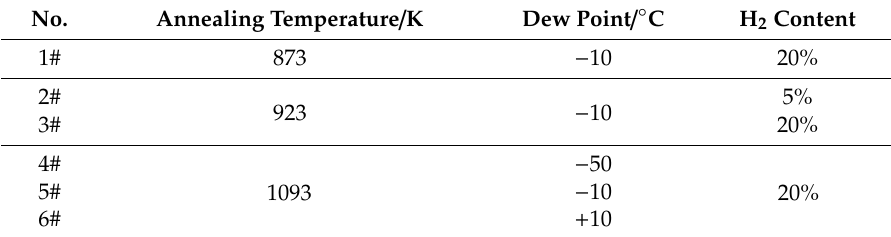
Table 1. The annealing process of medium manganese